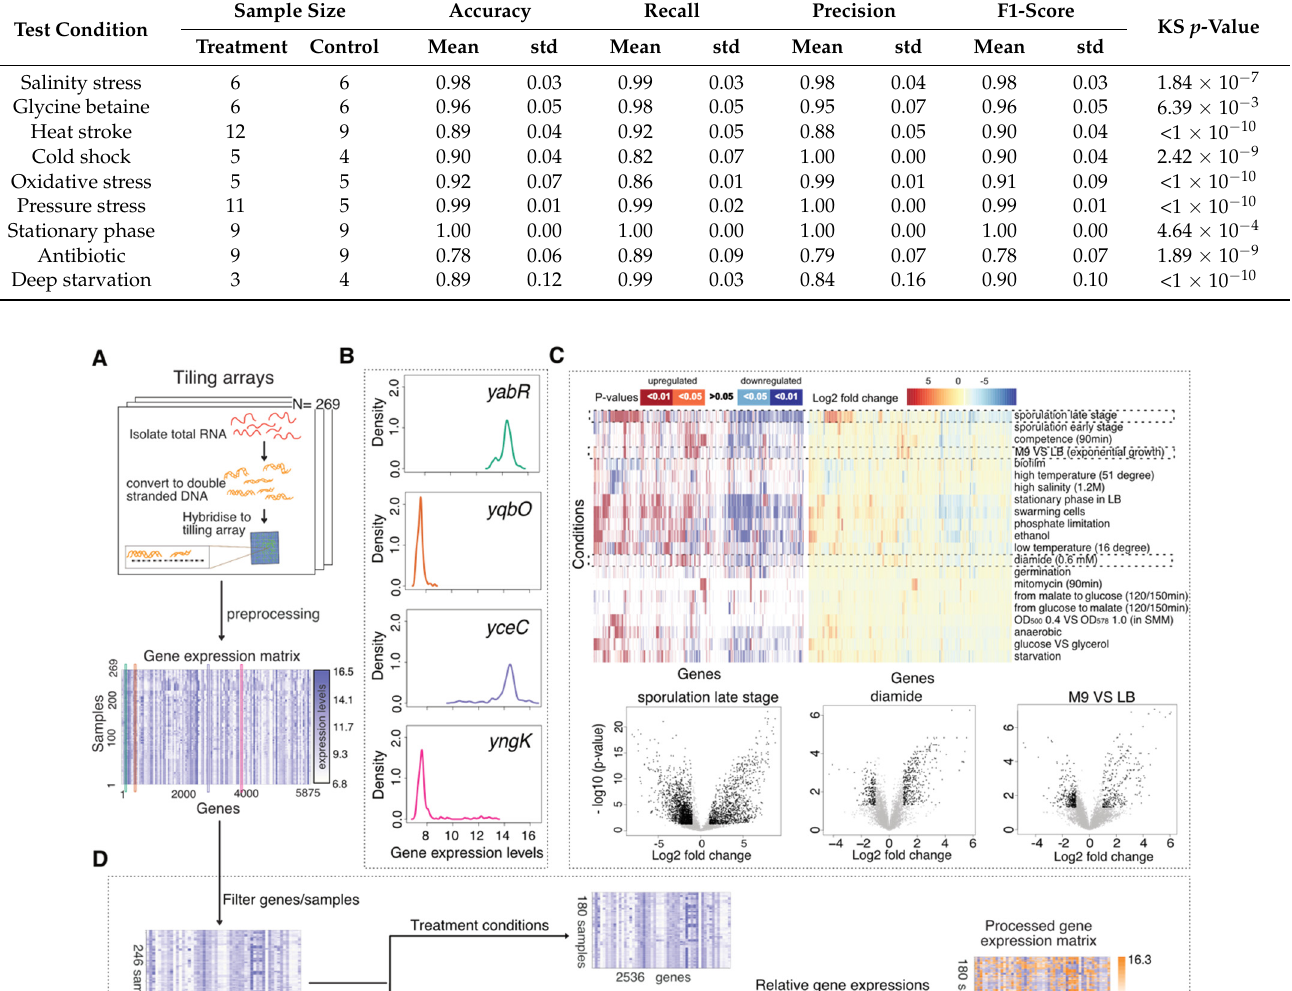
Table 2. Validation Performance.